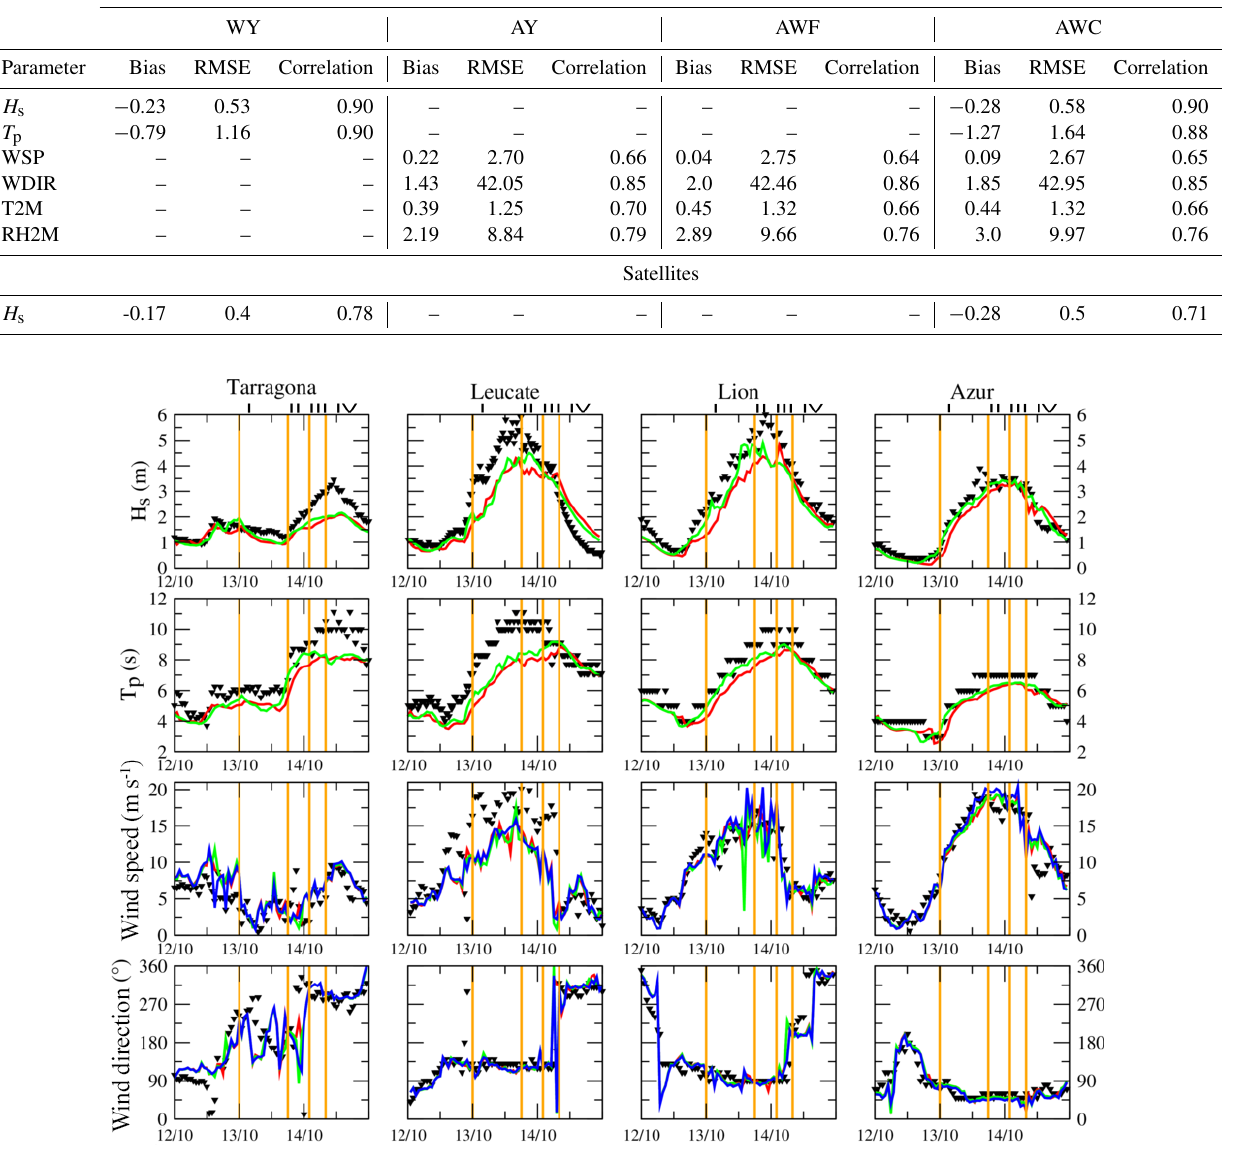
Figure 2. Evolution of H s (m), T p (s), wind speed (ms − 1 ) and wind direction ( ◦ ) simulated with AWF–WY (green), AWC (red) and AY (blue) against buoy observations (black